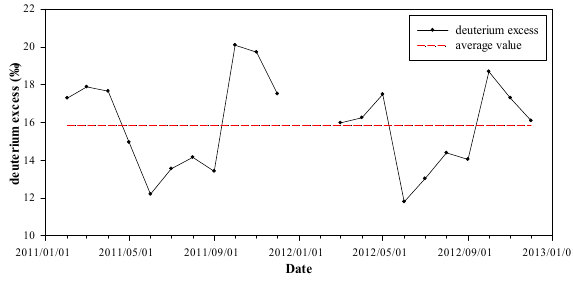
Figure 4. Seasonal variation in d –excess.